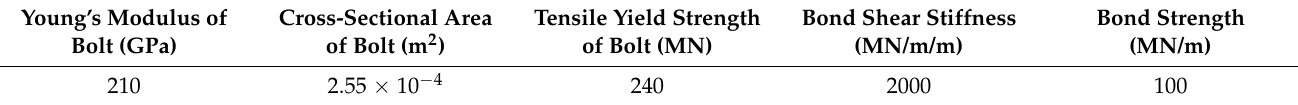
Table 3. Material property values used for rock bolt [16].